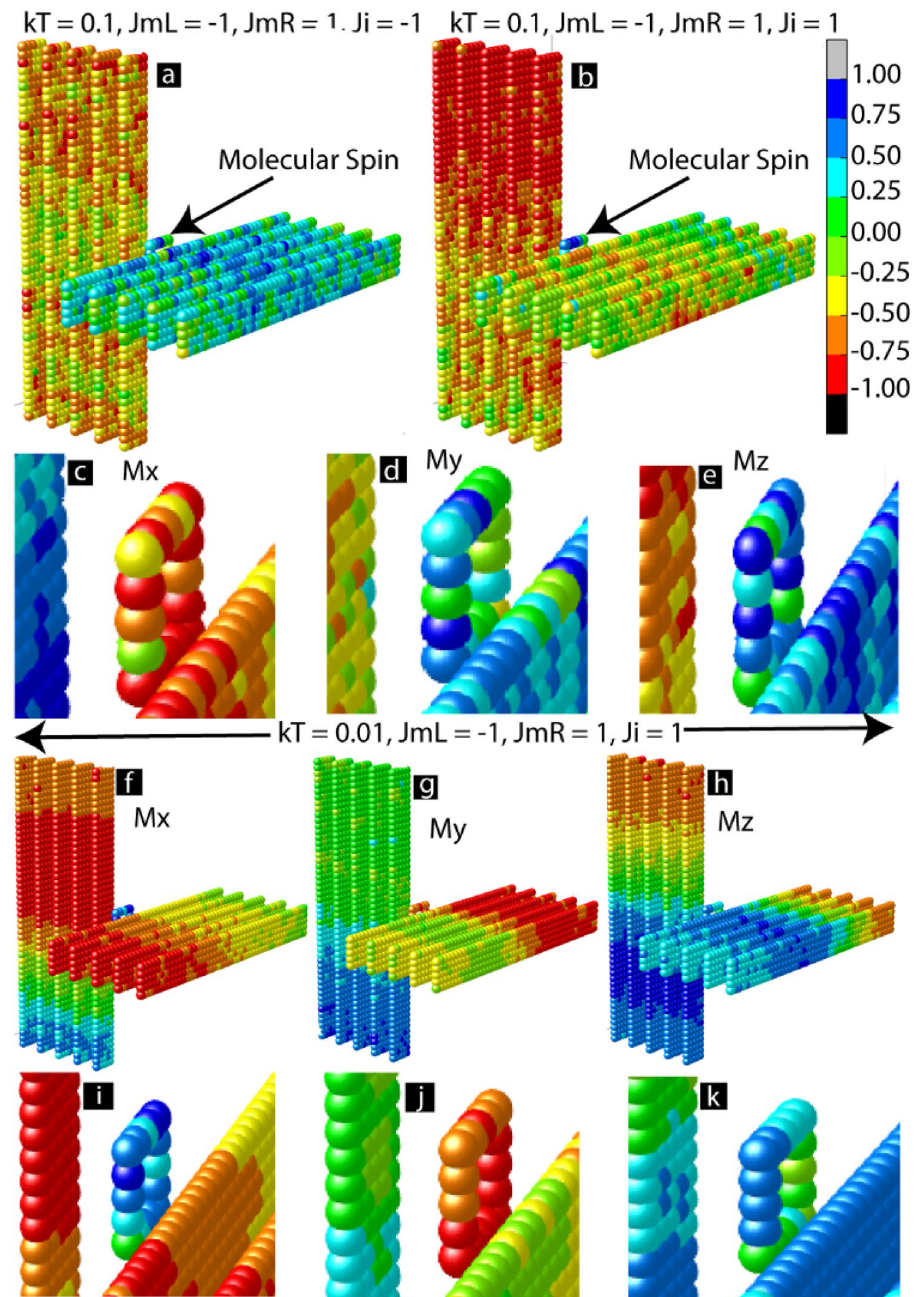
Figure 5. 3D Hisenberg model showing equilibrium state with MCS produced color of ferromagnet and molecules. MTJMSD equilibrium state magnetic moment when Ji is ( a ) supporting ( b ) opposing the molecule induced antiferromagnetic coupling. ( c ) X, ( d ) Y, and ( e ) Z component molecular magnetic moment as compared to ferromagnet near interface when Ji is opposing molecular coupling. At lower temperature ( kT = 0.01) when Ji is opposite to molecular coupling the magnetic moment of MTJMSD in ( f ) X, ( g ) Y, and ( h ) Z direction and magnetic moment near interfaces in ( i ) X, ( j ) Y, and ( k ) Z directions. This figure was plotted in Originlab ® 2020 version https:// www. origi nlab. com/ and components were assembled in Adobe Illustrator version available in adobe creative cloud package(https:// www. adobe. com/ creat ivecl oud.